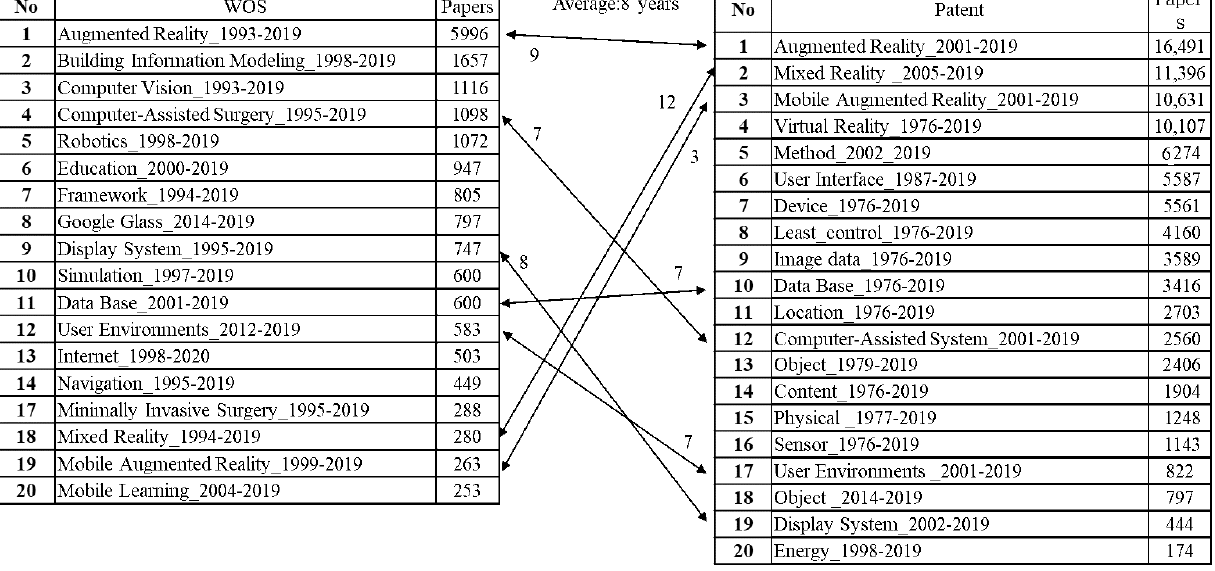
Figure 12. Time lag between the publication of academic and patent literature.